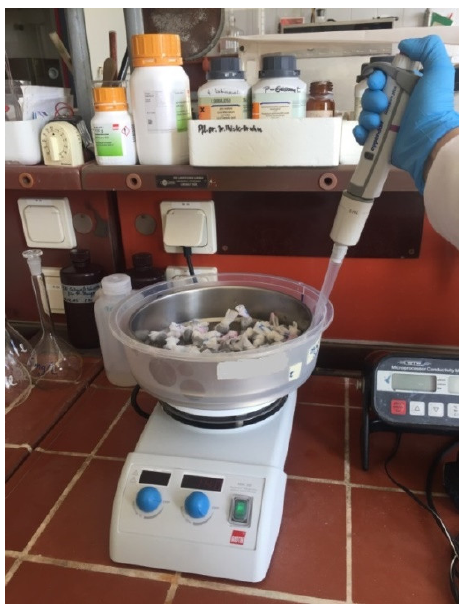
Figure 1. Soil aggregates wrapped in an inert nylon mesh on a sieve during the diffusion experiment.